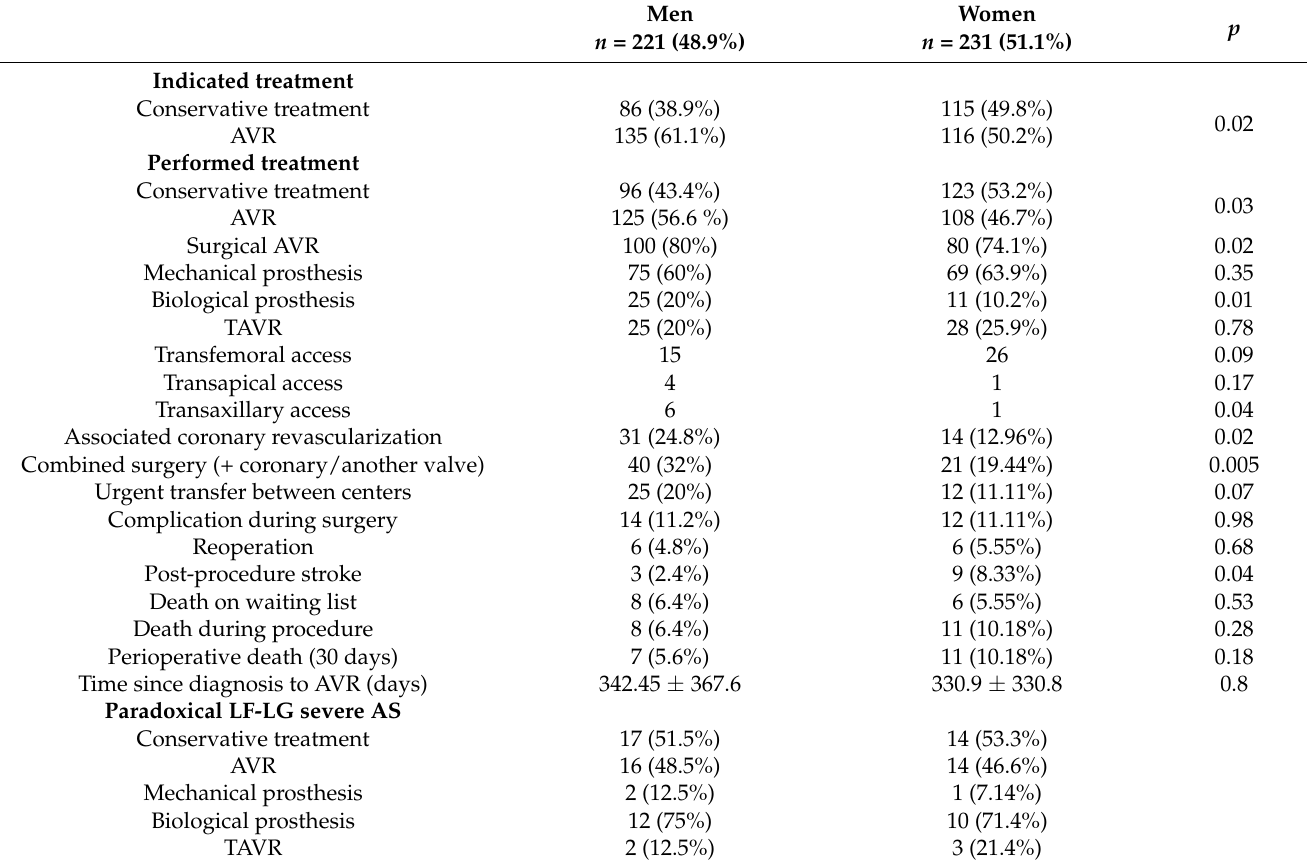
Table 3. Treatment according to